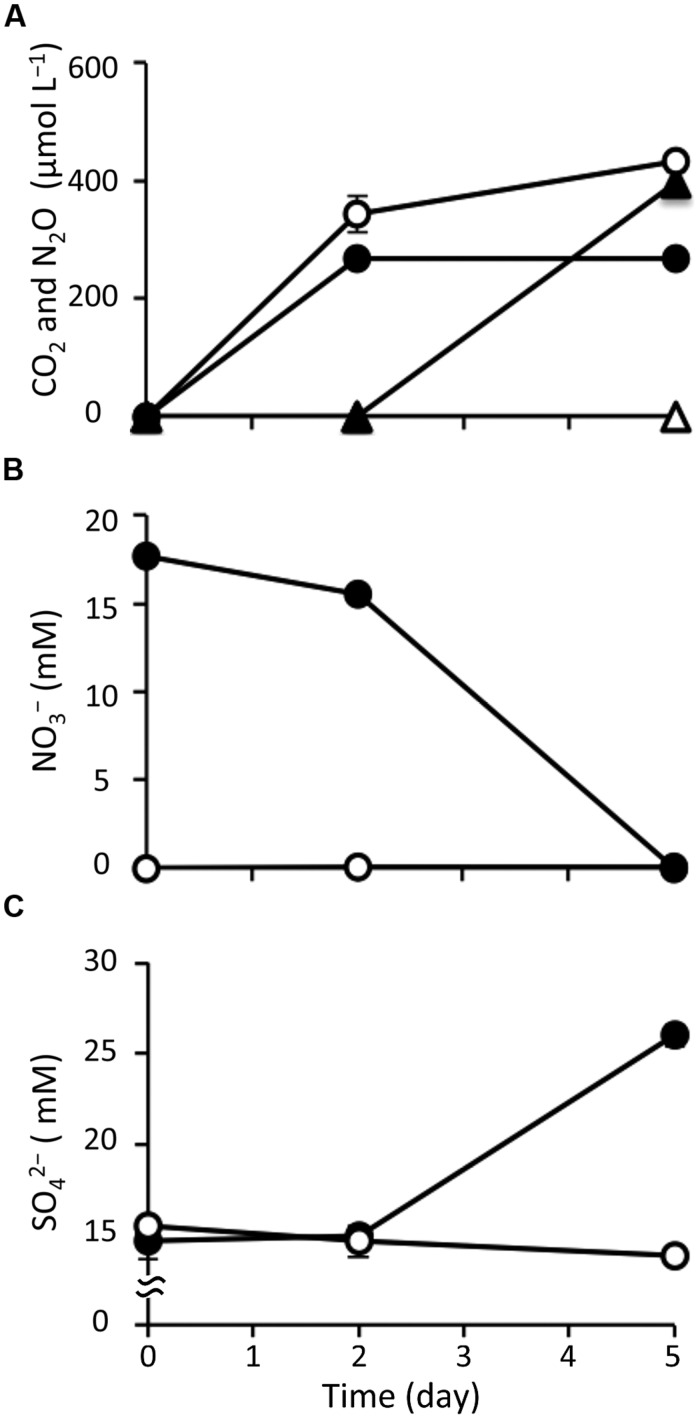
Changes in geochemical parameters during anoxic incubation of nitrate-amended marine sediments (closed symbols) and the control (opened symbols). The panels show the concentrations of CO2 (circle) and N2O (triangle) (A), nitrate (B), and sulfate (C). The error bars indicate the standard deviations of three replications.